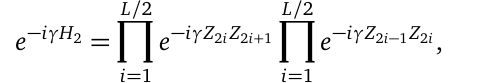
, β ) corresponding 1 1 Z and X respectively. Subse- i i + 1 i ) . For a total of p layers corresponding to , β n n